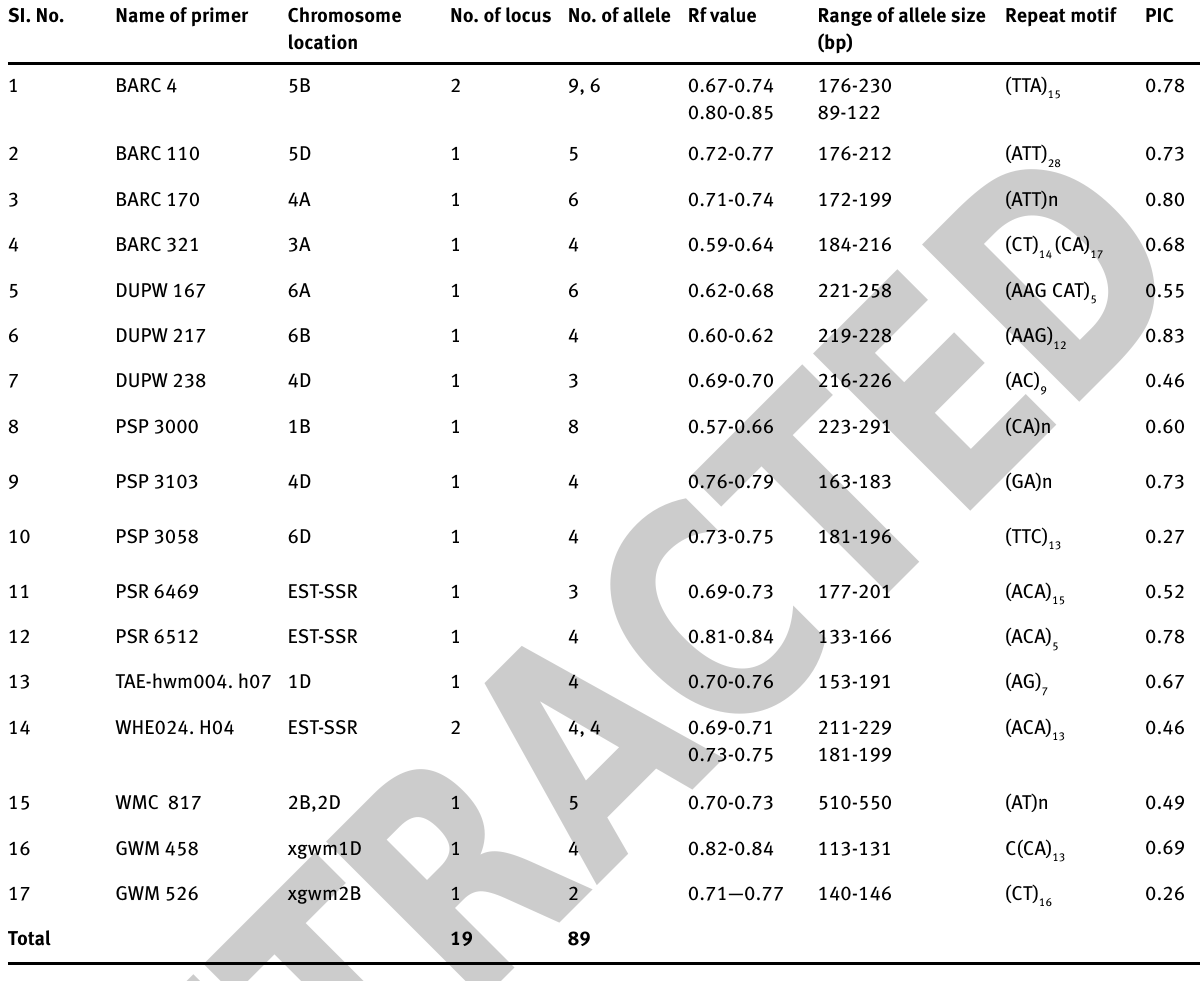
Table 6: Repeat motif, number of locus and allele detected, Rf value, range of allele size (bp) and PIC value of microsatellite markers used in the study SI.